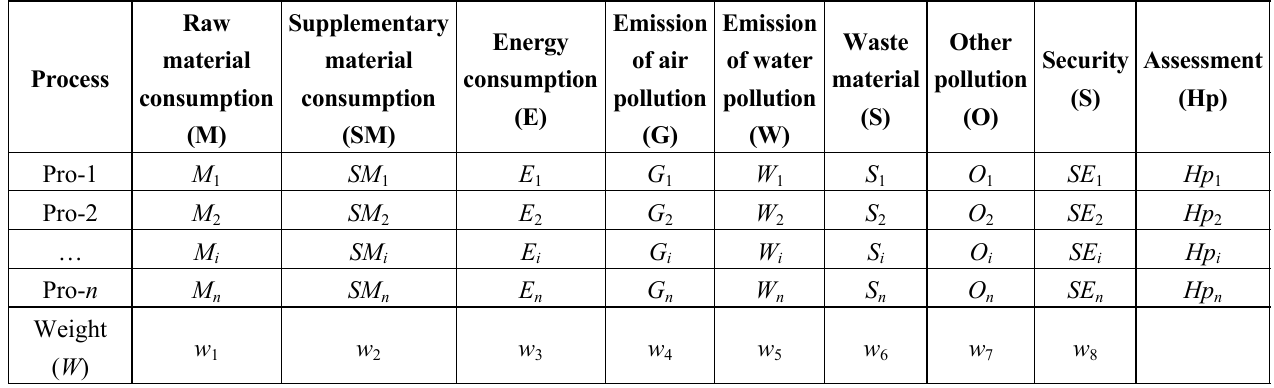
Table 3. Assessment of resource-environment characteristics in a component manufacturing process in terms of